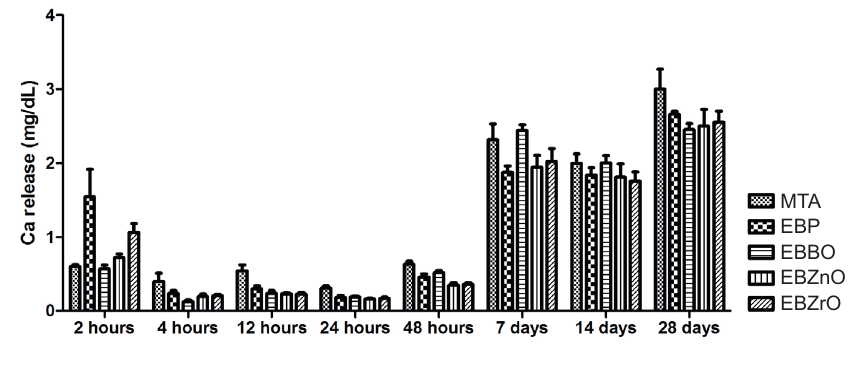
Figure 2 - Graphic representation of the calcium ion (mg/dL) release mean values at different time intervals.